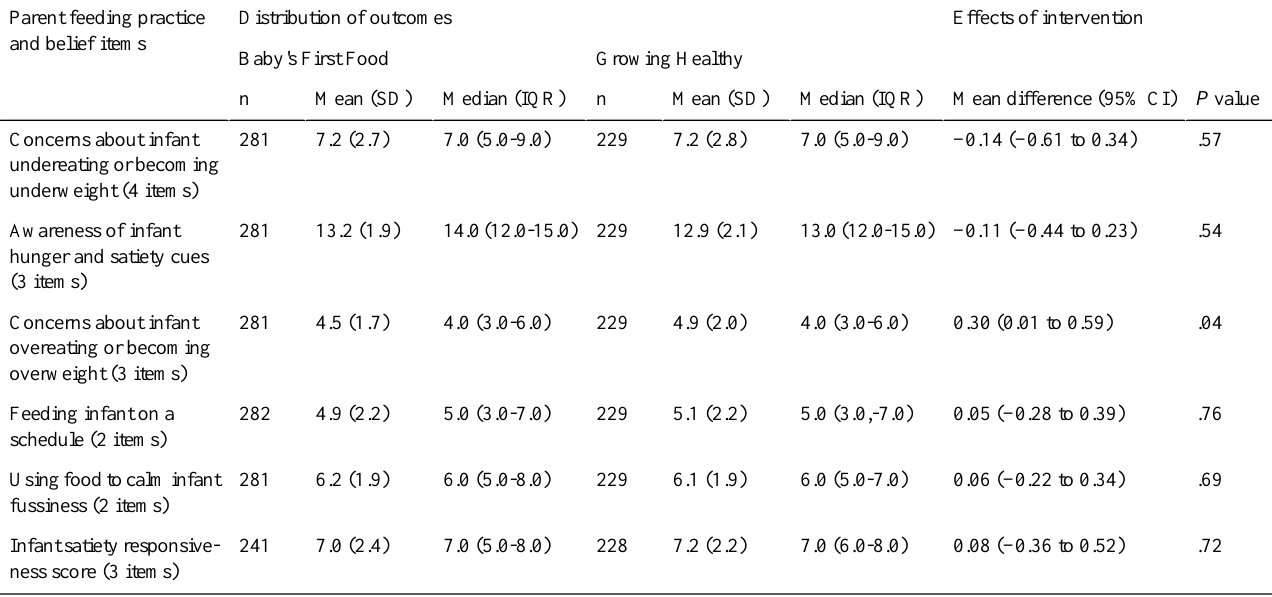
Table 3. Comparison of parent feeding practice and belief outcomes at time 2 between Baby's First Food and Growing Healthy. Mean difference coefficients estimated from linear regression analysis. IQR: interquartile